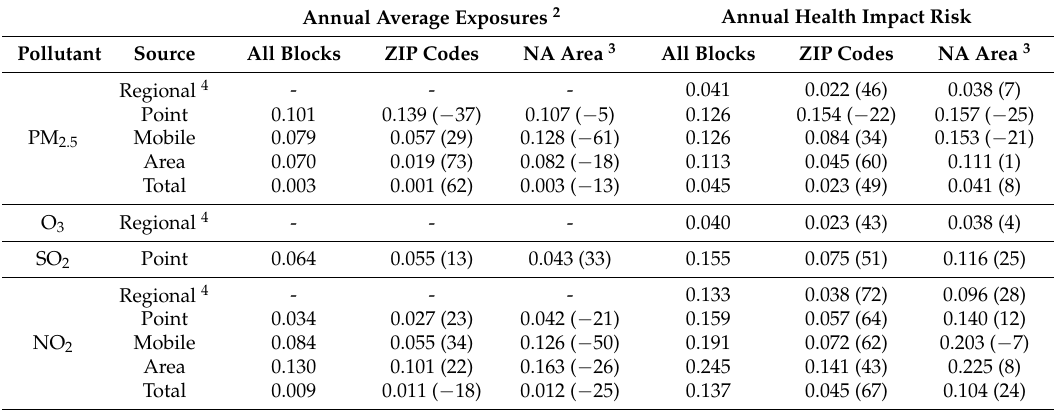
Table 3. Atkinson index (AI) 1 for annual average pollutant exposure and annual health impact (as risk of a DALY per year) attributable to individual pollutants for the full analysis, and for sensitivity analyses of spatial resolution and region. Percentages (in parentheses) show change from “all blocks”. Negative percentages indicate increases in